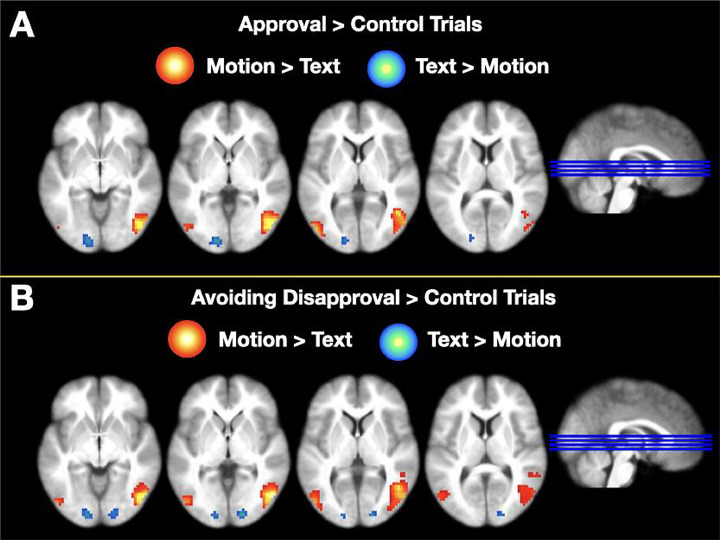
Group analysis for the motion > text, and text > motion contrast for the Seeking Approval task (A) and the Avoiding Disapproval task (B). All clusters presented are thresholded at p < 0.05 FDRcorrected and shown on a group-averaged T1-weighted image in MNI space.